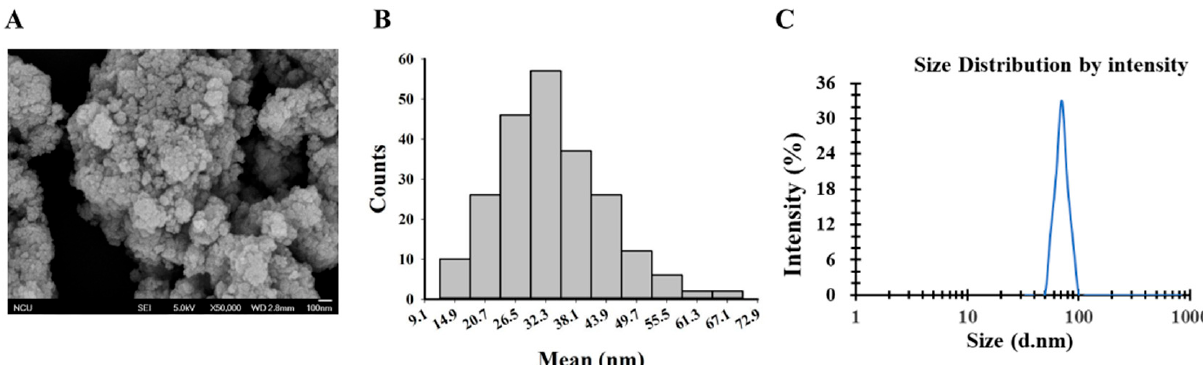
Figure 1. Characterization of titanium dioxide nanoparticles (TiO 2 NPs). ( A ) TiO 2 NPs have a spherical geometry as determined by SEM. ( B ) Particles diameter distribution at approximately 33 nm. ( C ) The approximate hydrodynamic size of the particles was 71 nm as determined by DLS analysis.